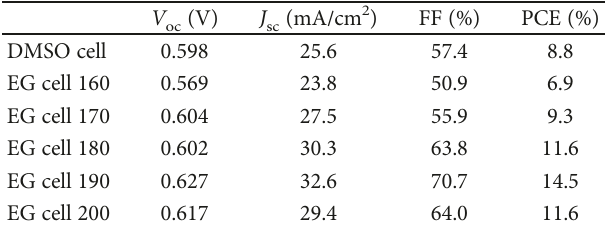
Table 1: Photovoltaic performance of n-Si/PEDOT:PSS solar cells under AM 1.5G illumination (100mW/cm 2